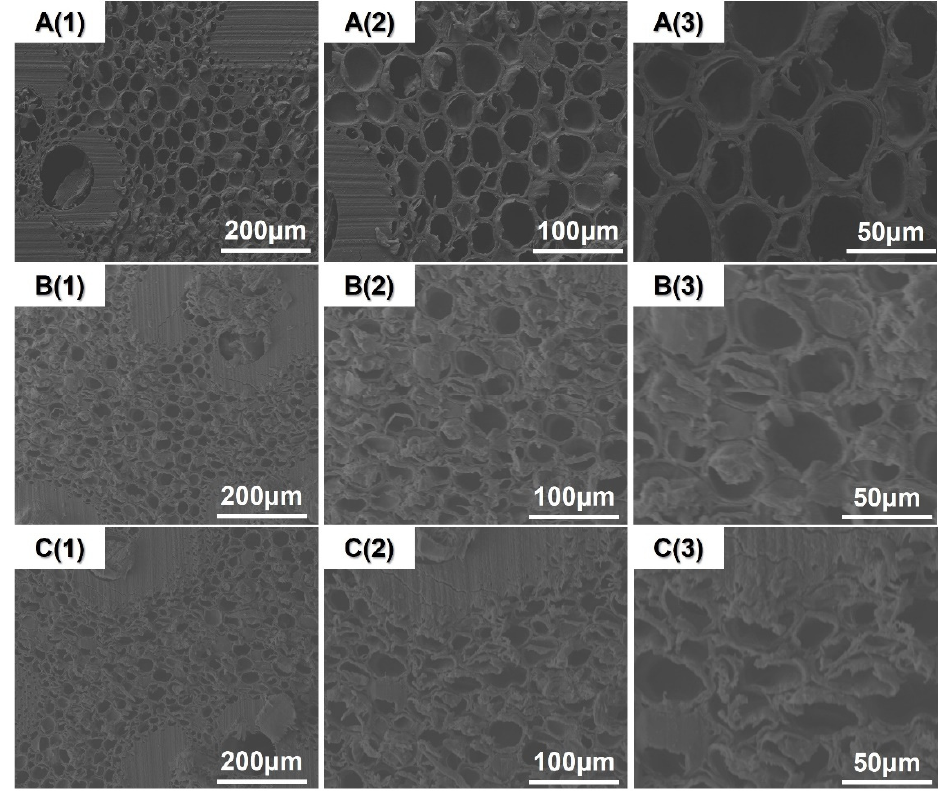
Figure 4. Bamboo samples treated at different temperatures and durations: ( A1 - A3 ) 150 °C/3 h; ( B1- B3 ) 170 °C/3 h; ( C1-C3 ) 190 °C/3 h .